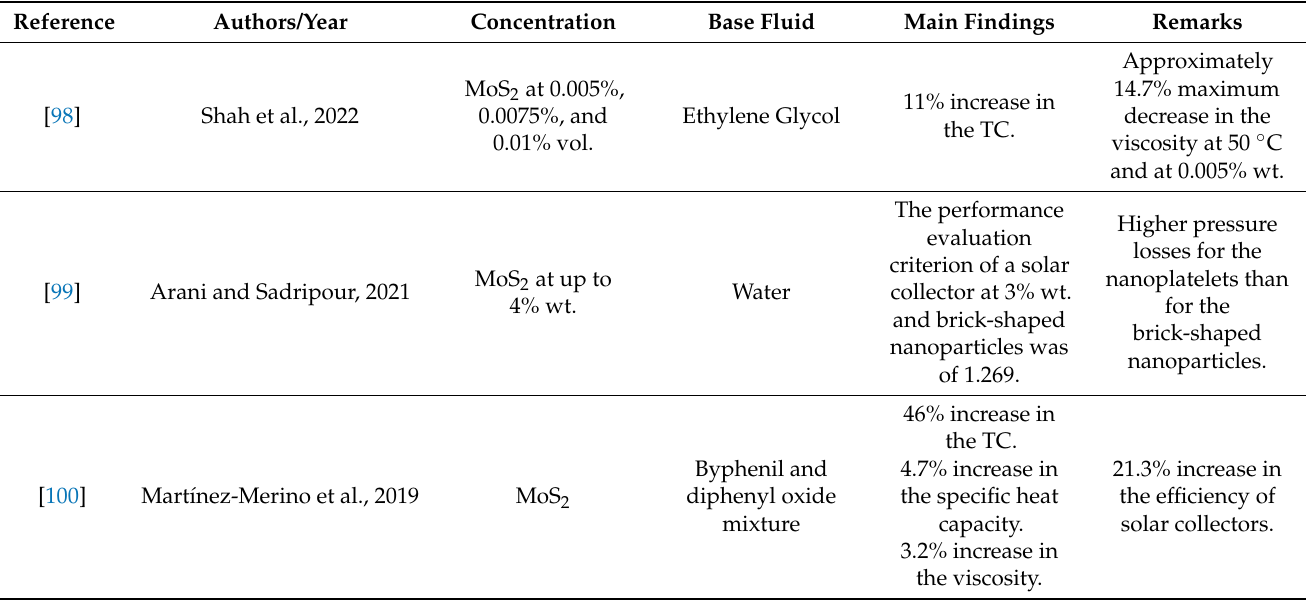
Table 4. Recent studies on 2D MoS 2 nanofluids.